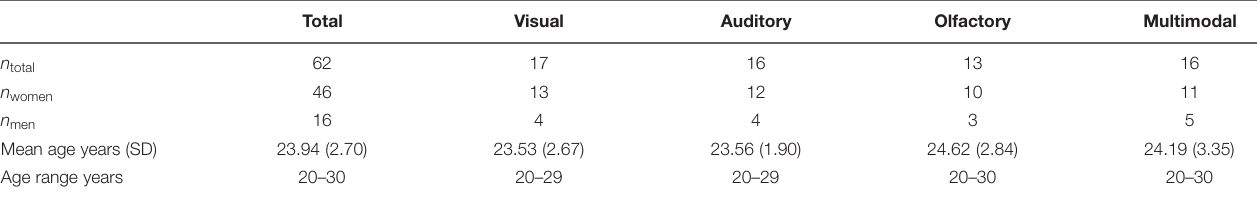
TABLE 1 | Participant information across the four conditions. Total Visual